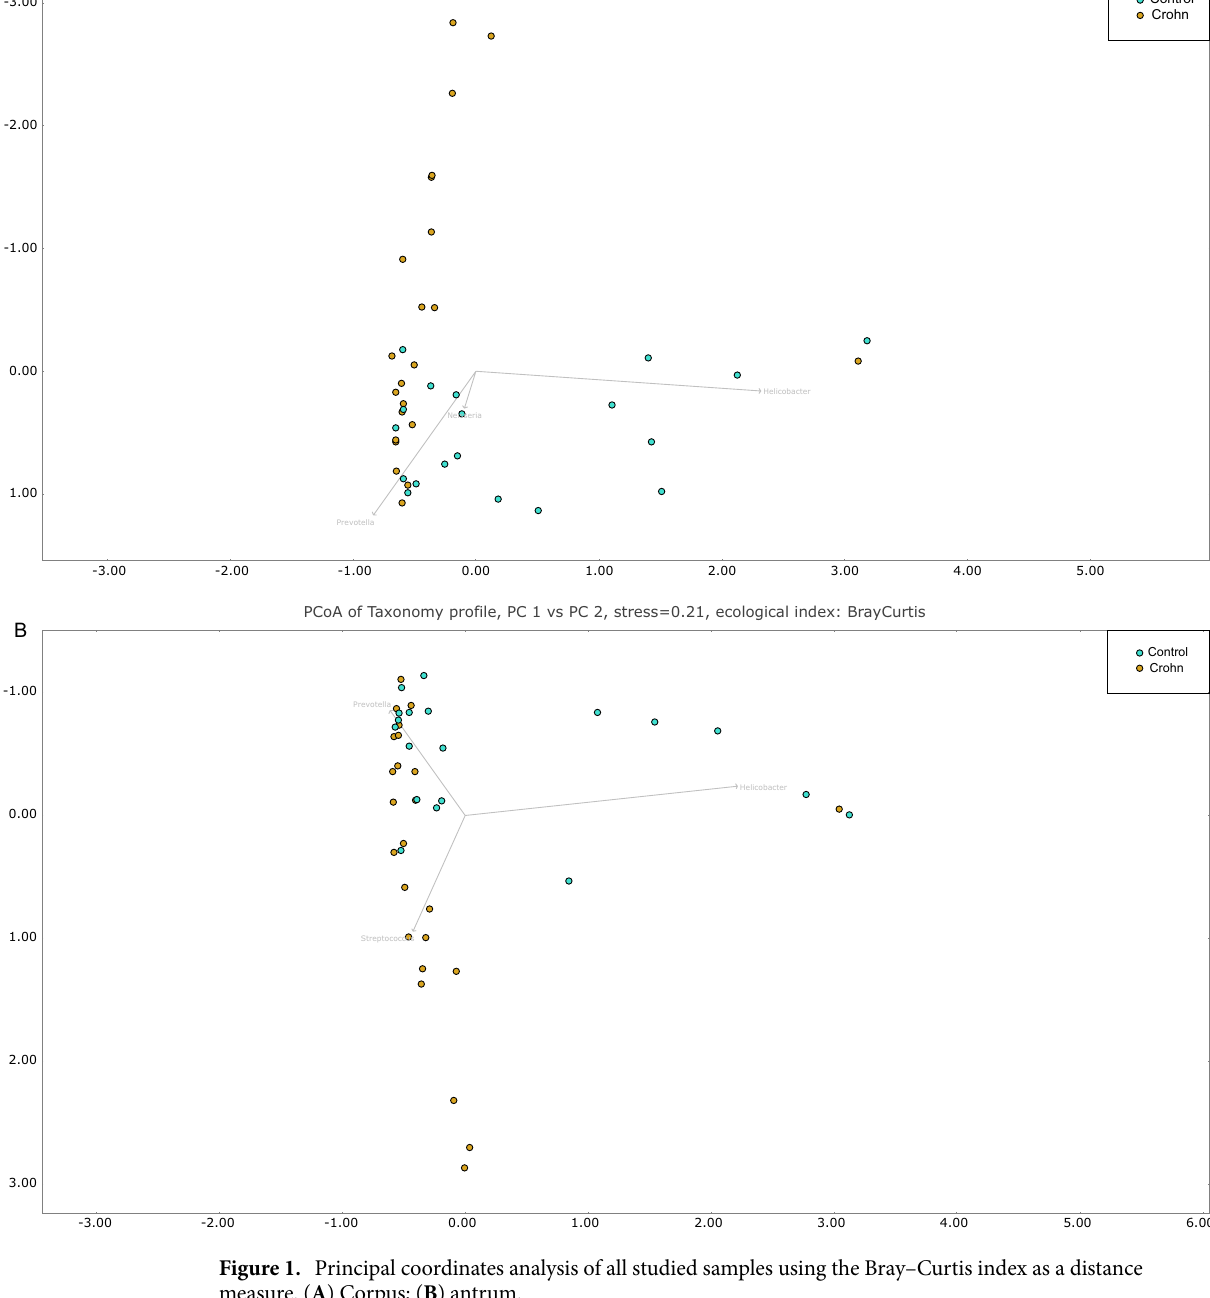
(Supplementary Table 2, Table 4): 3 each for corpus and antrum and only one for stomach liquid. Most of these taxa are in line with metagenomeSeq results.